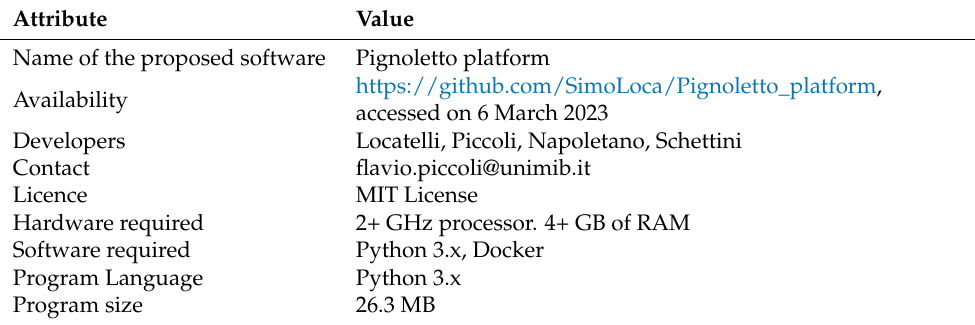
Table 2. Details of the